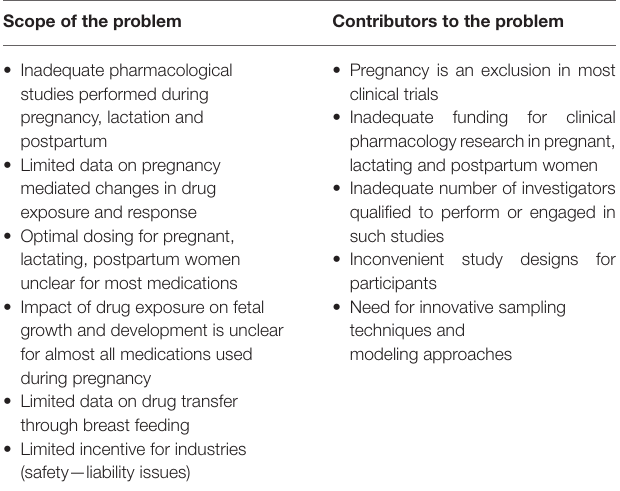
TABLE 1 | Need for designed pharmacological studies performed during pregnancy, lactation and